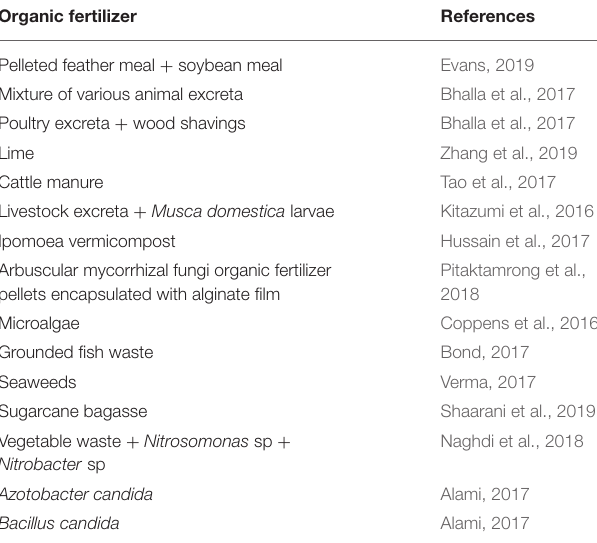
TABLE 3 | Scientifically formulated organic fertilizers. Organic